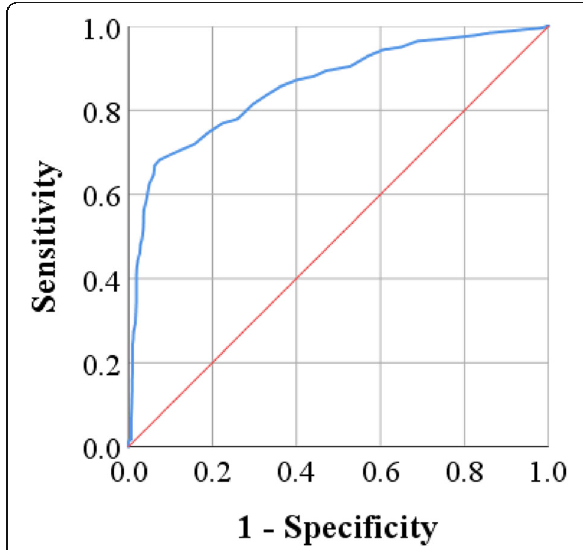
Fig. 3 Receiver operating characteristic (ROC) analysis of age in COVID-19 cases (area under curve = 0.858; 95% confidence interval 0.841 – 0.875; p <